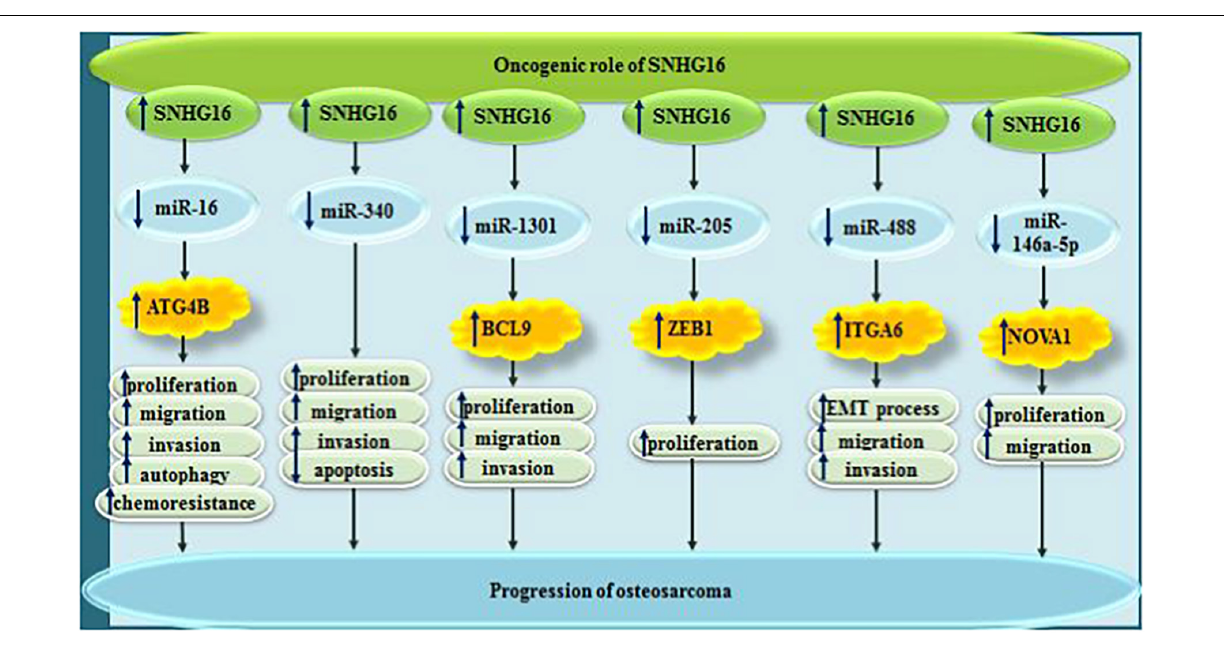
FIGURE 5 | Oncogenic roles of SNHG16 in